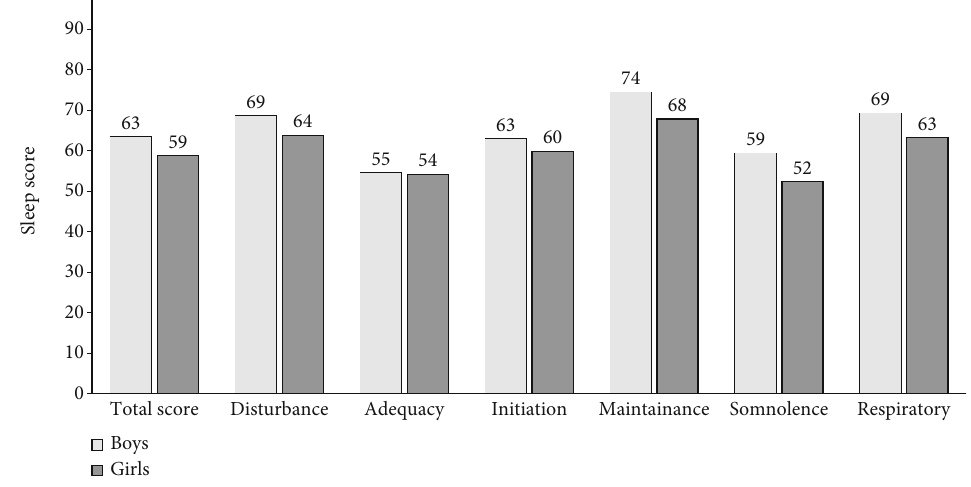
Figure 2: Sleep domain mean scores strati fi ed by gender ( n = 2206 ). Table 3: Multivariate linear regression with total sleep score as outcome.